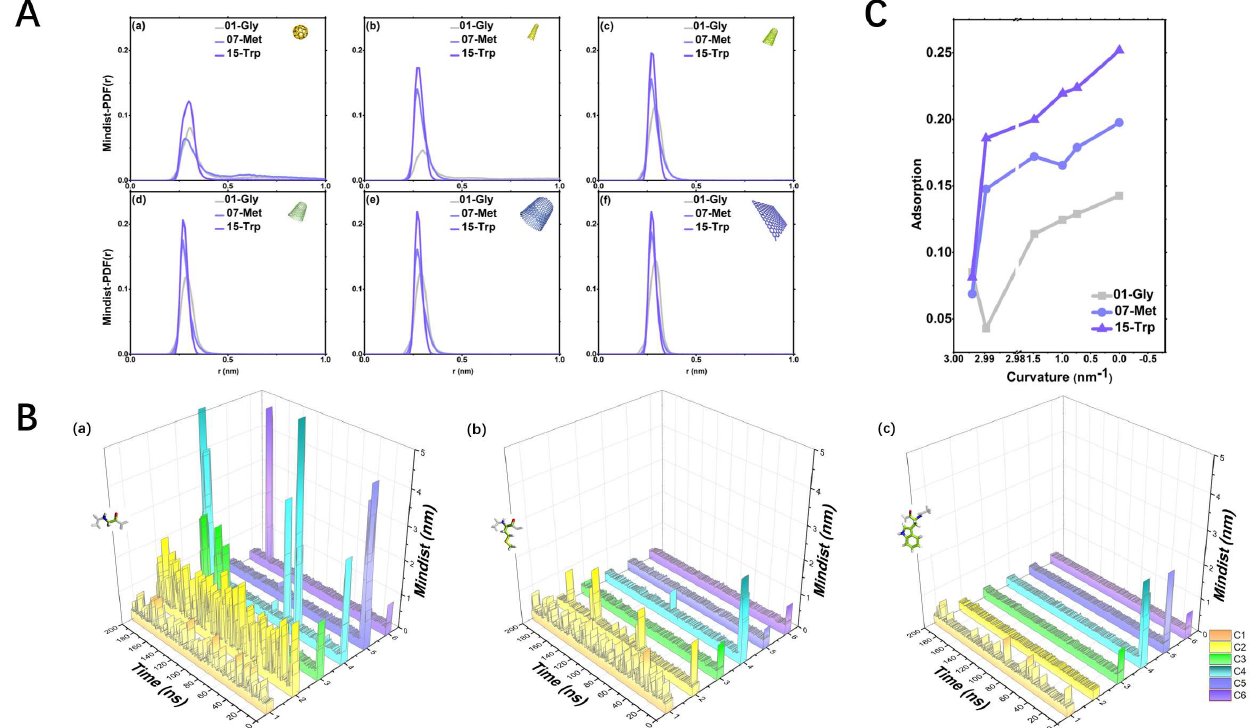
Figure 2. ( A ). Mindist-PDF(r): the distribution of minimum distances between three representative amino acids and CBNs. The grey line is 01-Gly, the blue line is 07-Met, and the purple line is 15-Trp; ( B ). Mindist: Variation of the minimum distances between three representative amino acids and six CBNs with time. C1 orange line is C60; C2 yellow line is CNT55L3; C3 green line is CNT1010L3; C4 bright blue line is CNT1515L3; C5 blue-purple line is CNT2020L3; C6 purple line is graphene33; ( C ). Adsorption: The adsorption trend in three representative amino acids, the grey dotted line is 01-Gly, the blue dotted line is 07-Met, and the purple dotted line is 15-Trp.